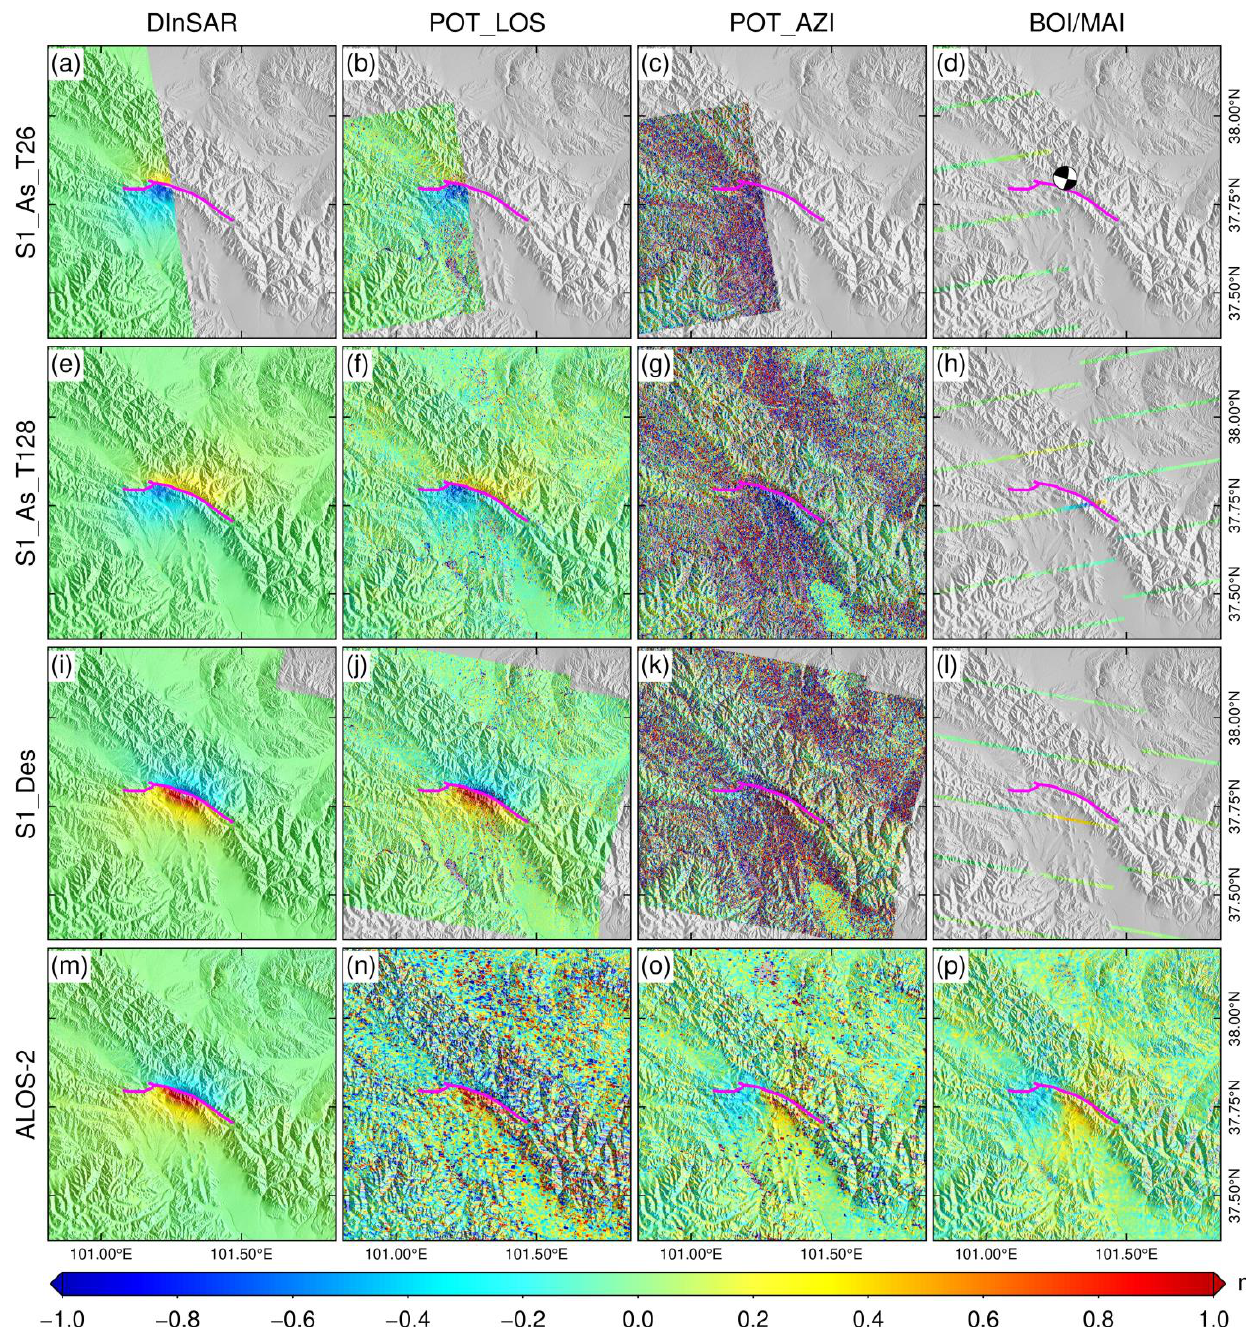
Figure 2. SAR displacement observations from the Sentinel-1 and ALOS-2 data. The magenta lines show the location of the ruptured fault trace, and the beach ball represents the focal mechanism and the epicenter location from the United States Geological Survey (USGS). For a better presentation of the complete displacement pattern, the beach ball is only drawn in ( d ). ( a – d ) are SAR observations from ascending Sentinel-1 data of track 26, ( e – h ) are from ascending Sentinel-1 data of track